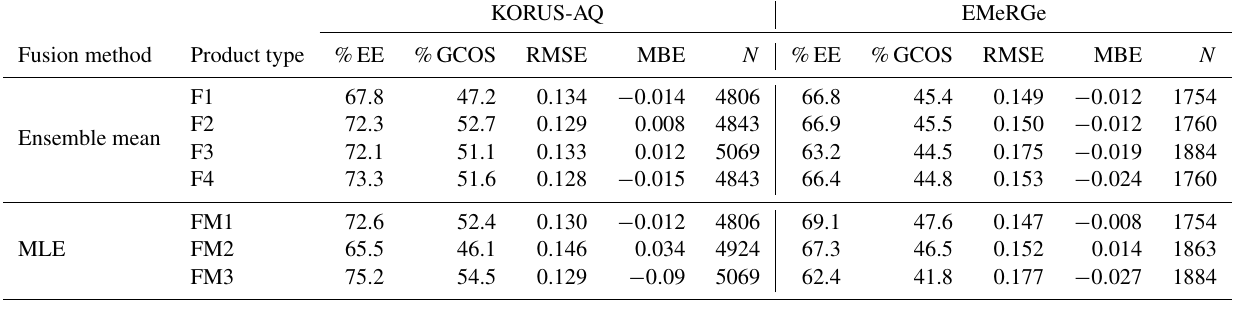
Table 3. Validation statistics of the ensemble-mean fusion (F1–F4) and MLE fusion (FM1–FM4) AOD during two field campaigns (left: KORUS-AQ; right: EMeRGe).